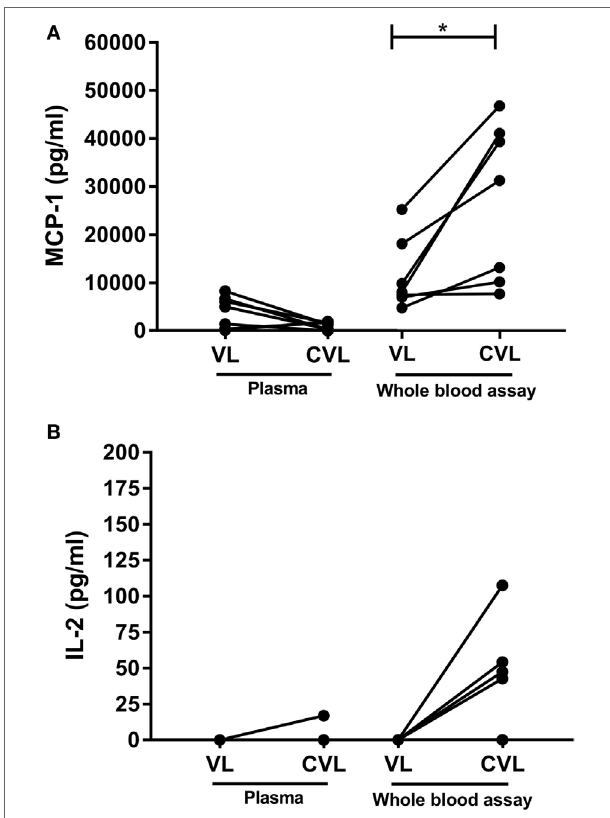
FiGUre 1 | Levels of monocyte chemotactic protein 1 (MCP-1) (A) and IL-2 (B) in natural plasma and soluble Leishmania antigen (SLA)-stimulated plasma in active visceral leishmaniasis (VL) patients compared to cured VL (CVL) after 6 months of treatment. Levels of MCP-1 and IL-2 before and after treatment were analyzed using Wilcoxon matched pairs signed rank test, * p < 0.05.